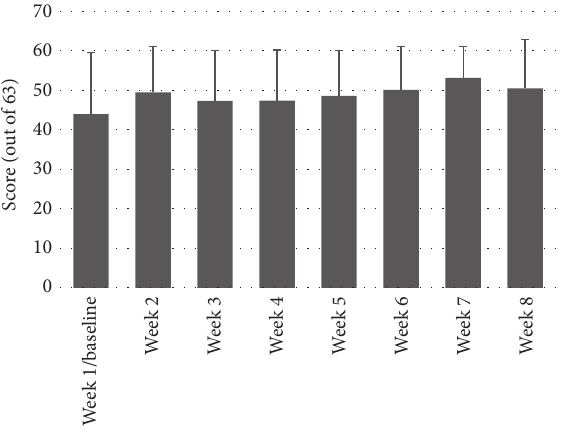
Figure 5: Week-by-week Fatigue Severity Scale